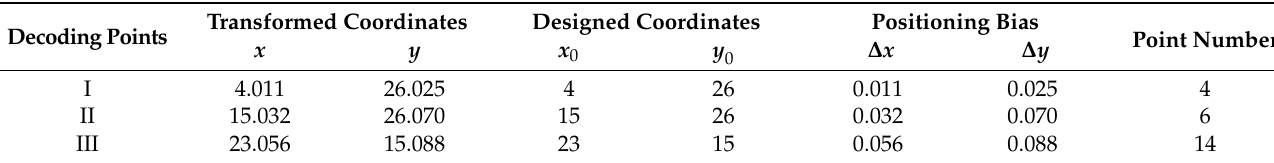
Table 5. Decoding of a GCT (unit: mm).